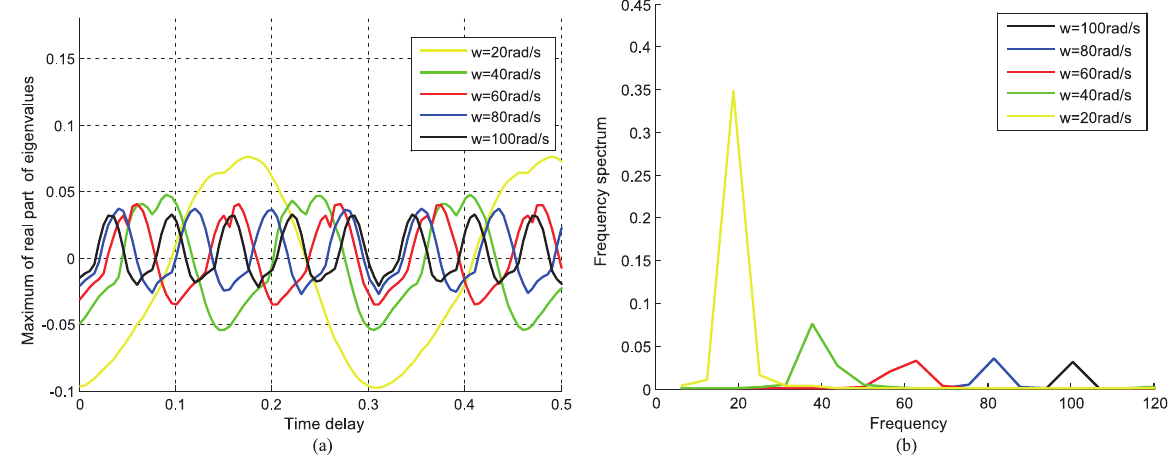
Fig. 8. Effect of time delay on the stability of DVBG DVA, (a) the largest values of the real parts of characteristic roots; (b) frequency spectrum. For the four semi-active DVAs, the first-order perturbations of the steady-state solutions have the same forms as Eq. (26), where the differences are based on the entries A ij ( i = 1 , . . . , 4 , j = 1 , . . . , 4 ). Due to the